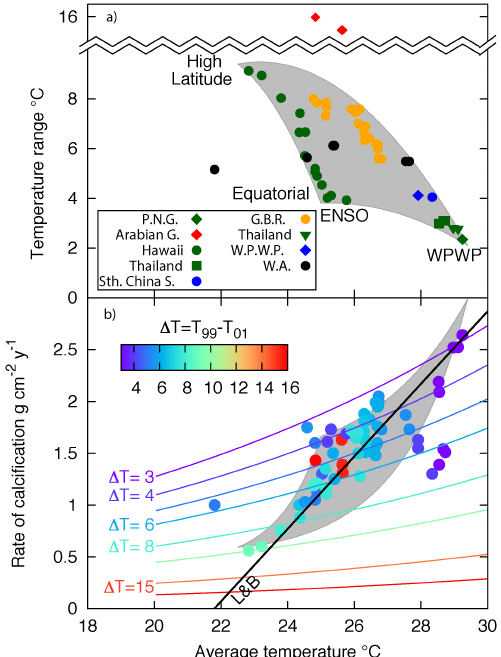
Figure 12. The upper panel shows the average and range of SST from the 0.25 ◦ × 0.25 ◦ NOAA SST (Reynolds et al., 2007) for each coral location. The family of Arrhenius curves in the lower panel maps out a large area of possible calcification rates, while the sym- bol colours show the adapted range. Overlain on this plot is the linear relationship of Lough